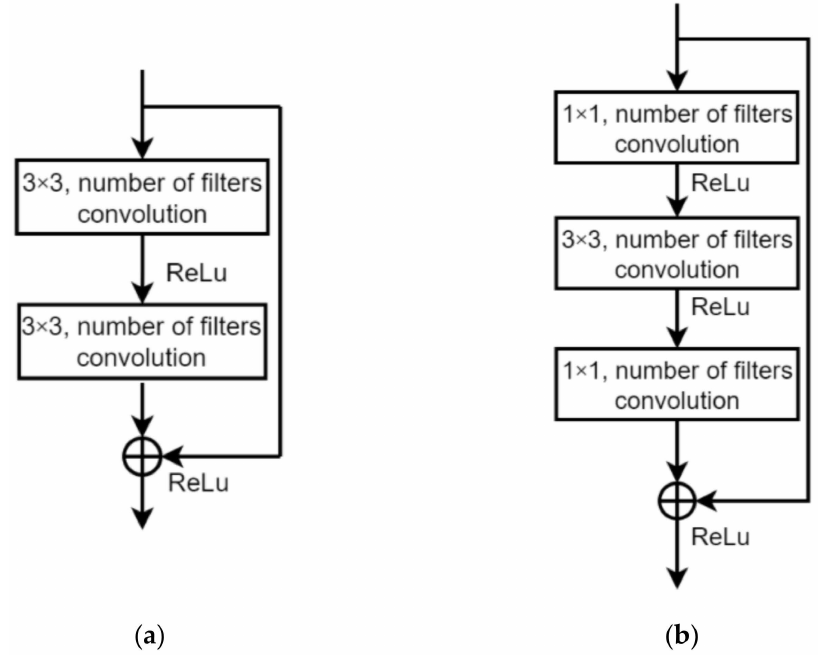
Figure 6. Residual module structure. ( a ) ResNet18, ( b ) ResNet50.